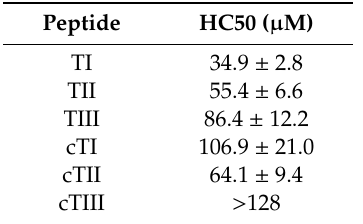
Figure 2. The peptide stability in human serum and activity against human red blood cells (RBCs). ( a ) Stability of TI and cyclic analogue cTI in 25% ( v / v ) human serum for 24 h. The samples were analyzed by analytical RP-HPLC and the percentage of peptide remaining was determined from the area under the peptide peak in the chromatogram in comparison to peak area at time zero. A linear 18 amino acid peptide (KGGGGSGQLIDSMANSFV) was included as the positive control. ( b ) Hemolytic activity of tachyplesins and their cyclic analogues were tested up to 128 µM against human RBCs (0.25% ( v / v ), 1 h incubation at 37 °C). Melittin, a highly hemolytic peptide, was included as the positive control. Table 2. Concentration of tachyplesin I–III (TI-TIII) and of their cyclic analogues (cTI-cTIII) required to induce 50% lysis in RBCs (HC50). a.